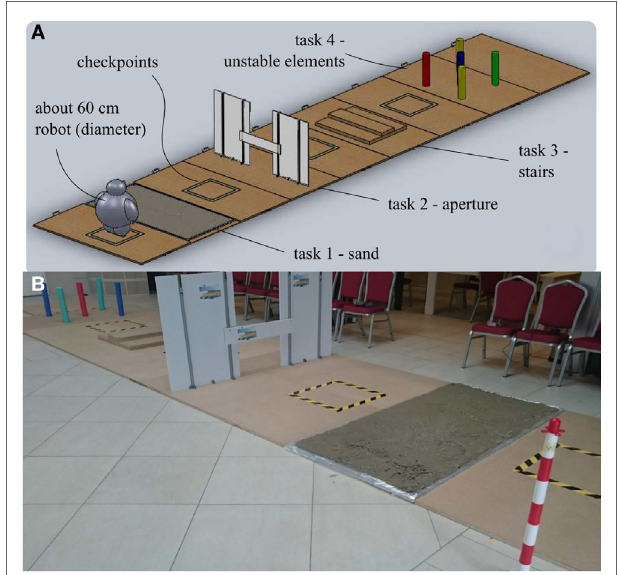
FIGURe 2 | the locomotion scenario was made of four tasks separated by checkpoint tiles . Picture (A) shows the CAD model, picture (B) shows the actual